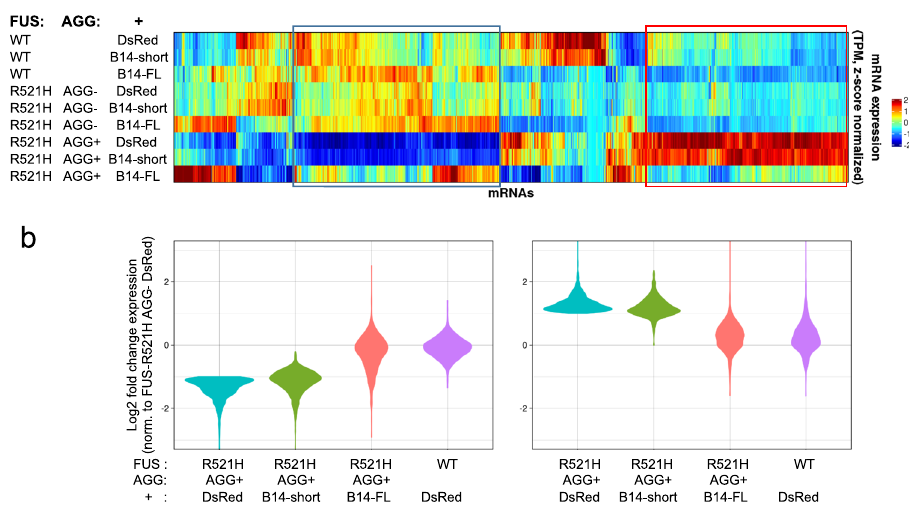
Fig. 6 DNAJB14-FL restored deteriorated proteostasis caused by mutFUS aggregation. a Hierarchical clustering analysis of RNA-seq mRNA expression (mean TPM of replicates, z-score normalized) in FUS-WT and mutFUS aggregation experiments, where cells were co-transfected with either DNAJB14-FL, DNAJB14-short, or DsRed as control. Aggregate-containing cells (AGG + ) and non-aggregated mutFUS cells (AGG-) were FACS-sorted. The two largest clusters in the data (blue and red rectangles) contain mRNAs either induced (red) or repressed (blue) in the presence of mutFUS aggregates in both DsRed and DNAJB14-short co-expressing cells. b Distribution plots (violin plots) of the Log2 fold change values of differentially expressed mRNAs (DEGs, see “ Methods ” ) identi fi ed in mutFUS aggregate-containing cells (AGG + ) co-expressing DsRed (blue). A similar distribution is shown in mutFUS AGG + DNAJB14-short co-expressing cells (green), while co-expression of DNAJB14-FL in mutFUS AGG + cells (pink) shows a distribution highly similar to WT- FUS cells (purple), demonstrating restoration of gene expression. Left panel — downregulated DEGs. Right panel — upregulated DEGs, both de fi ned in FUS- R521H-YFP + DsRed, AGG +